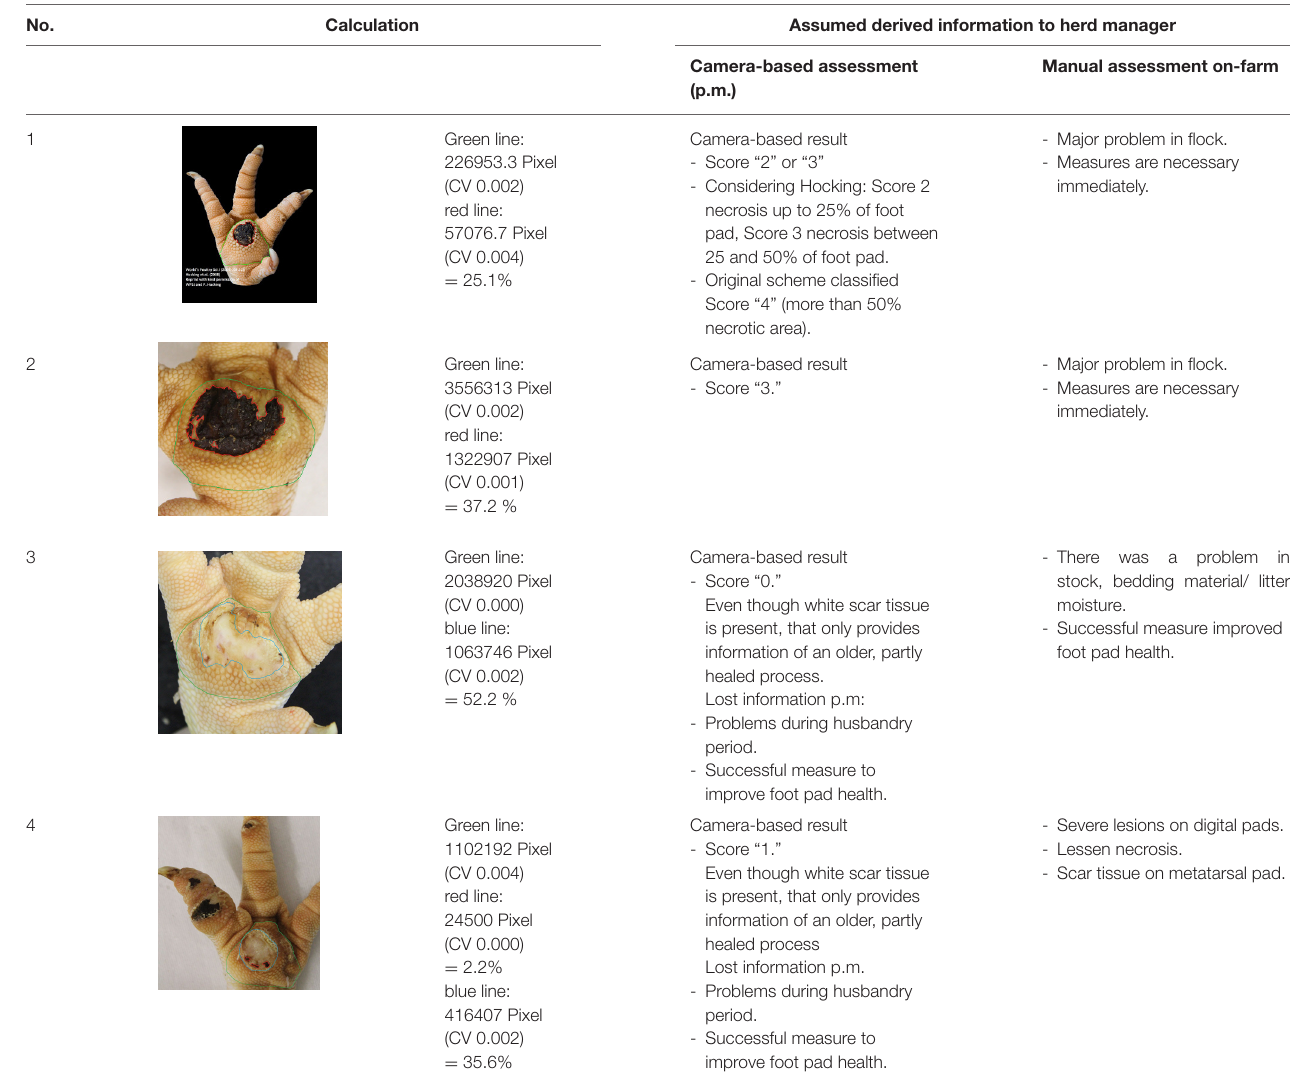
TABLE 4 | Calculation and description of macroscopic foot pad alterations [green line: 100% metatarsal pad; red line: detected necrotic (black) area: blue line: scarred tissue; three samples per figure; mean value (pixel) and coefficient of variation (CV)]. No. Calculation Assumed derived information to herd manager Camera-based assessment